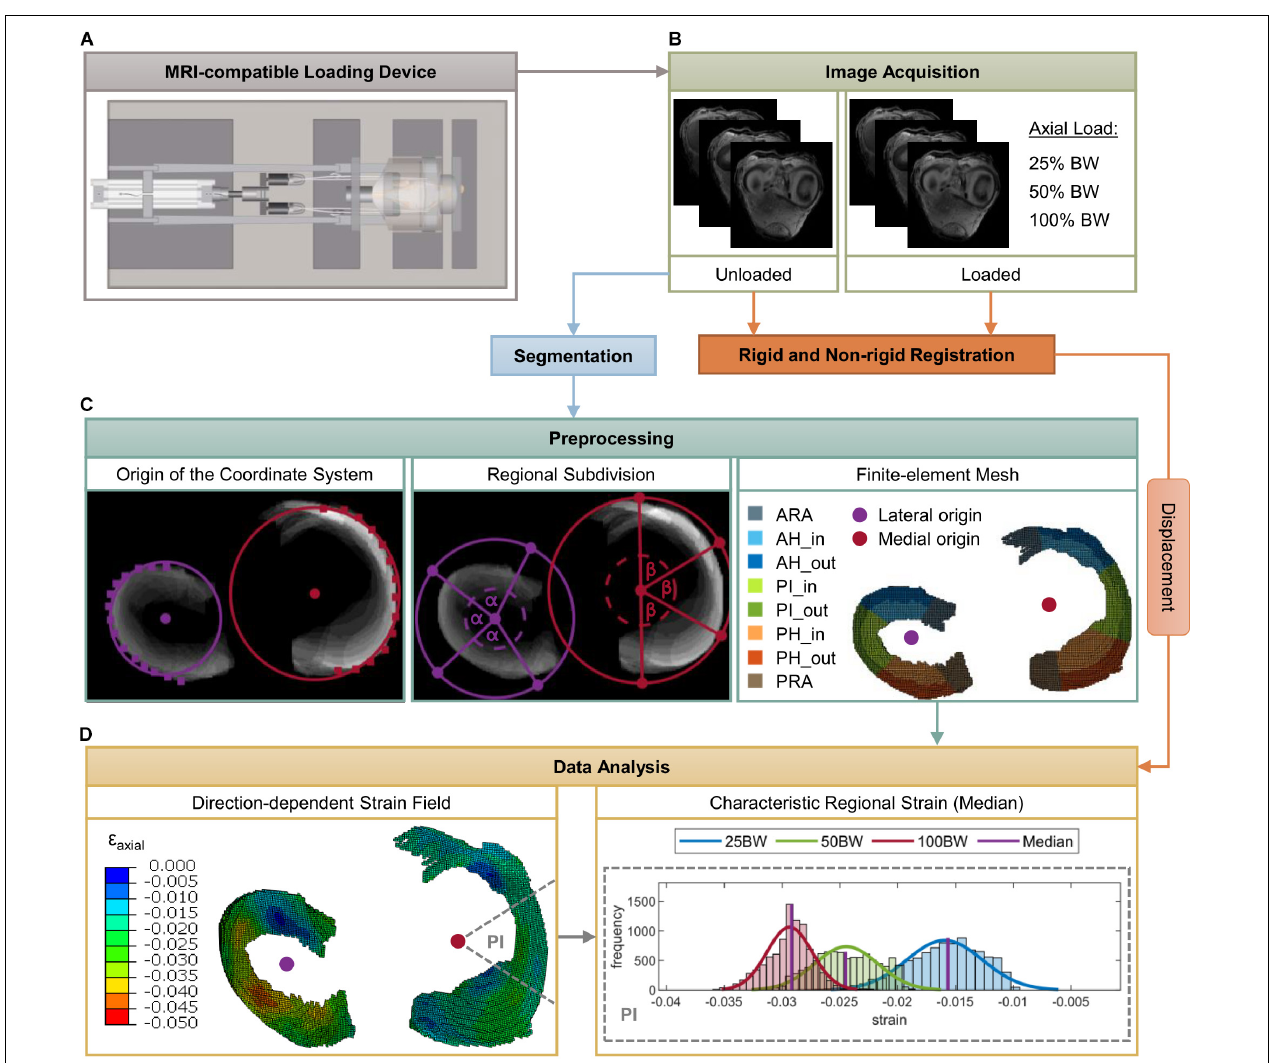
FIGURE 2 | Schematic overview of the methodology of the present study. Mild and severe degenerated knee joints were mounted in an MRI-compatible loading apparatus (A) at 5 ◦ extension. Subsequently, image sequences were acquired for both unloaded and loaded conditions [25%, 50%, 100% body weight (BW)] (B) . Intensity-based rigid and non-rigid registration were performed to obtain the deformation of the menisci under the respective loads. Based on three-dimensional voxel models of the medial and lateral menisci, which were obtained by segmentation of the unloaded image sequence, a hexahedral finite-element (FE) mesh was created (C) . Furthermore, lateral and medial origins for the definition of cylindrical coordinate systems were determined and the menisci were subdivided into five anatomic regions (ARA = anterior root attachment; AH = anterior horn; PI = pars intermedia; PH = posterior horn; PRA = posterior root attachment) as well as in an inner and outer circumference (C) . Finally, nodal displacements were applied to the FE mesh, strain fields in the axial, circumferential and radial directions were calculated and characteristic regional (median) strain values were determined for the subsequent statistical analyses (D) .